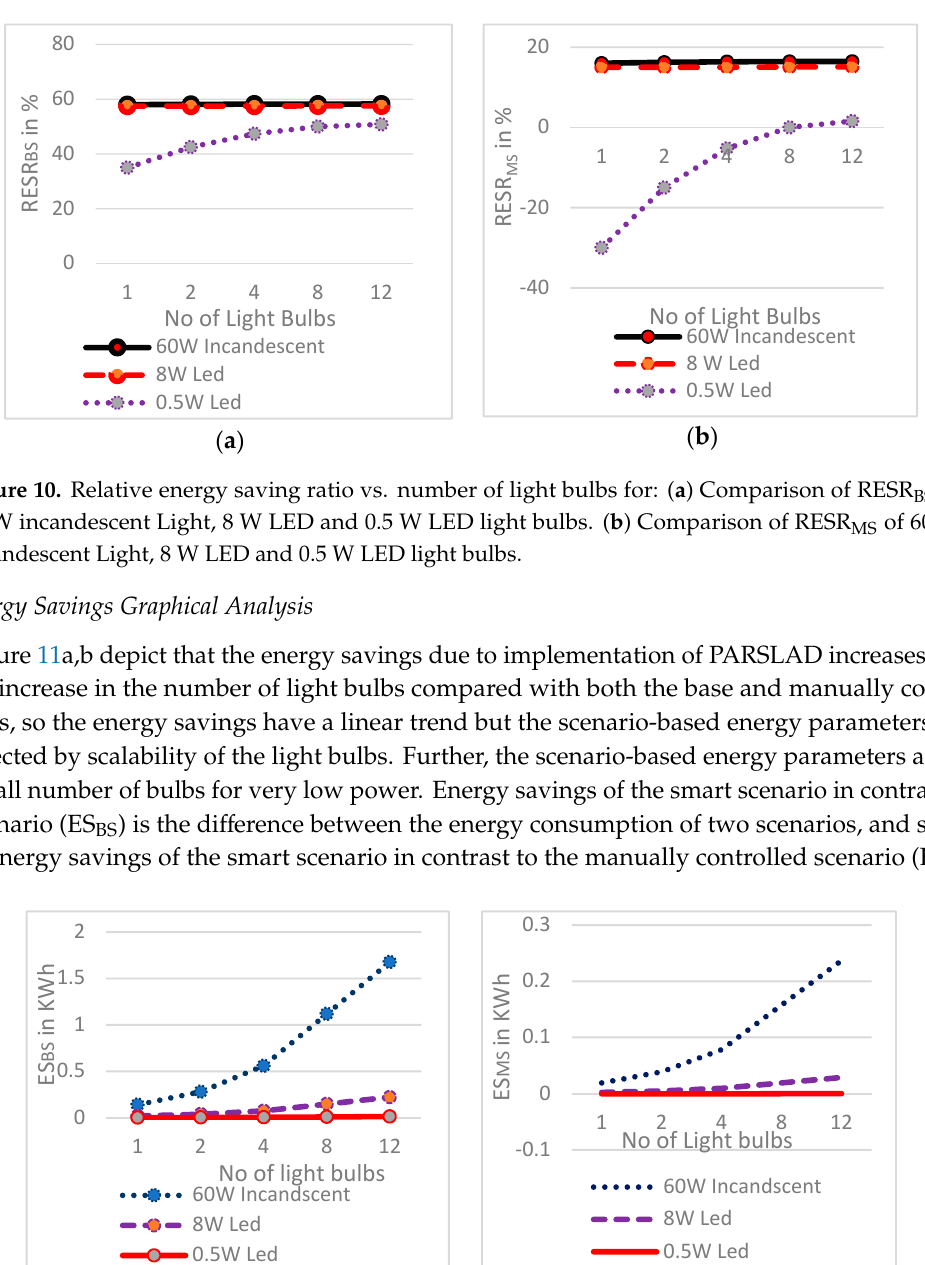
Table 12. Cost consumption analysis of light bulbs under diverse conditions and scenarios.